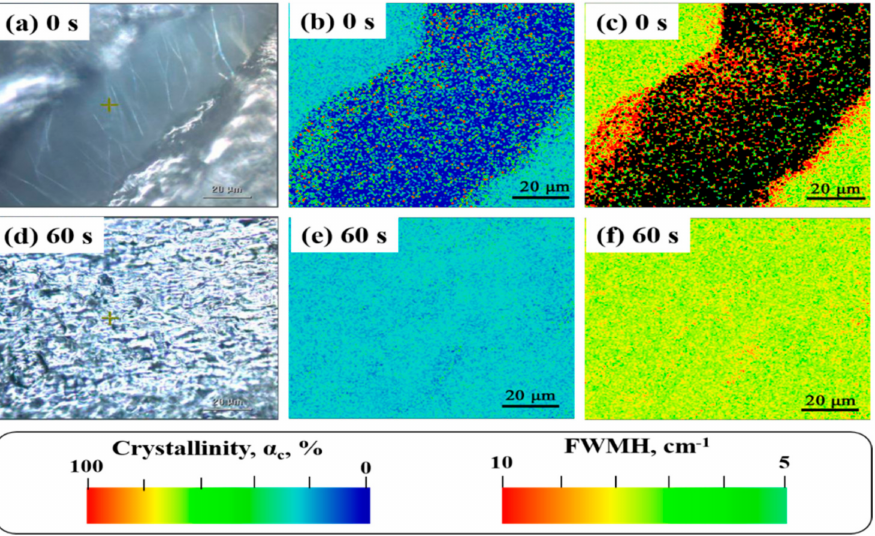
Figure 2. Extruded UHMWPE samples with different residence time of 0 s and 60 s. ( a , d ) Optical mi- crograph; ( b , e ) crystallinity distribution of Raman mapping; ( c , f ) FWMH (at 1130 cm − 1 ) distribution of Raman